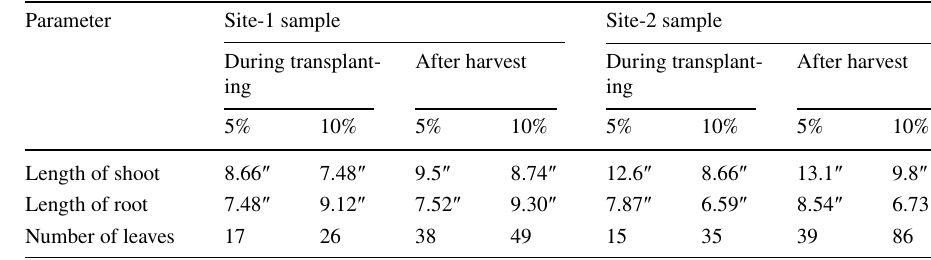
Parameter Site-1 sample Site-2 sample During transplant- After harvest During transplant- After harvest ing ing